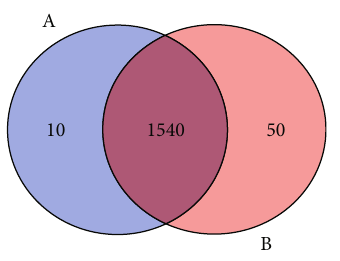
Figure 1: Venn diagram analysis of genes between Leishmania martiniquensis (LU_Lmar_1.0) genome from the NCBI database (a) and Leishmania martiniquensis from our study